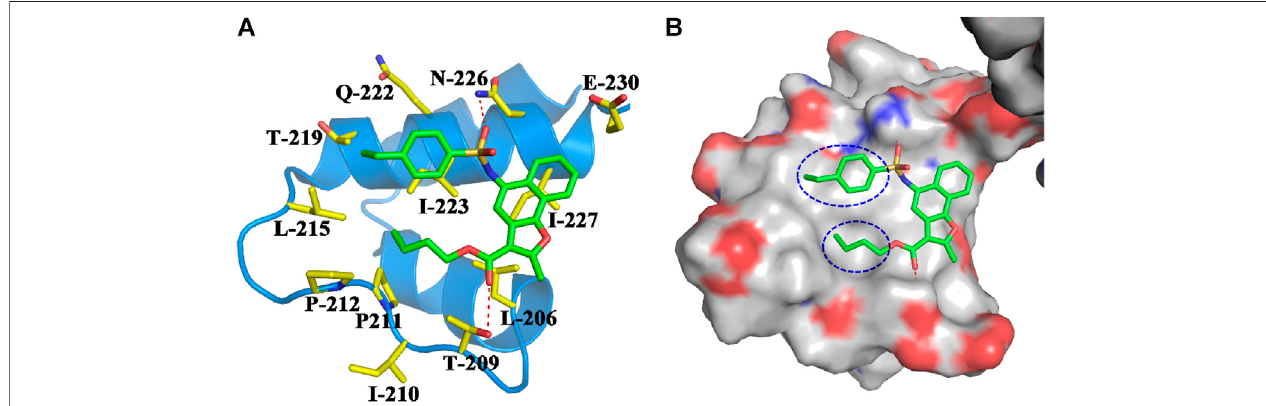
FIGURE 4 | (A) Binding mode of compound M1 within the NTD of SIRT1. Compound M1 and the key residues for its binding were all shown in stick model, and colored in green and yellow, respectively. The NTD of SIRT1 was shown in cartoon model and colored in blue. (B) Compound M1 bound in the hydrophobic groove of NTD.